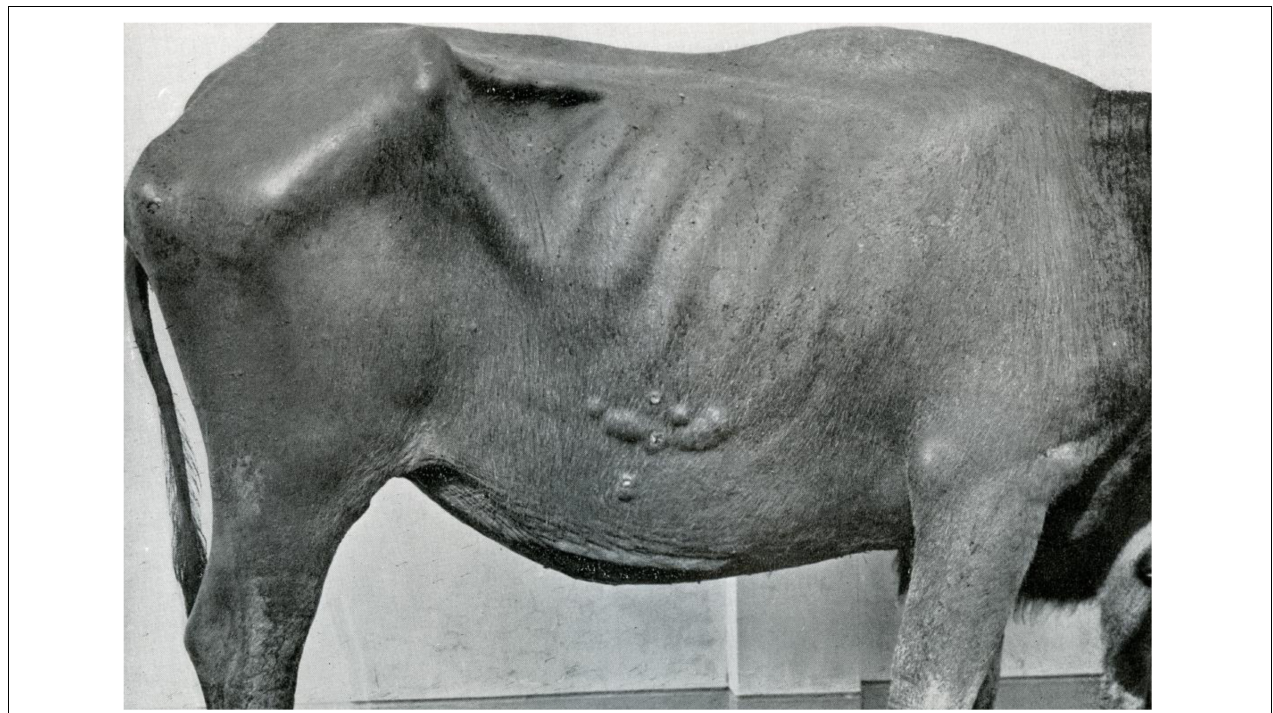
FIGURE 1 | Lesions in water buffalo confined to one skin area.